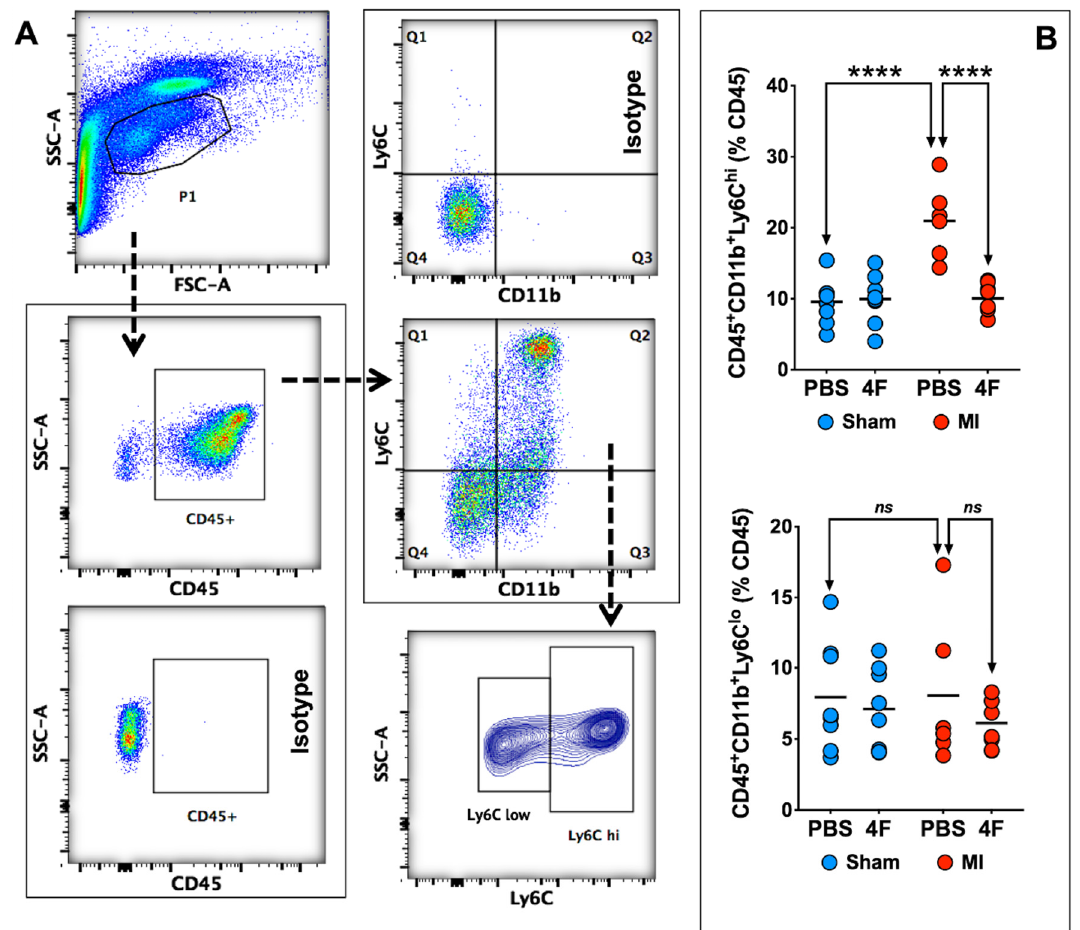
Figure 2. L-4F suppresses blood pro-inflammatory monocyte levels. ( A ) Gating strategy for flow cytometric evaluation of peripheral blood monocytes. CD45 + cells within the lymphocyte/monocyte gate (P1) were further gated on the basis of CD11b and Ly6C expression. Pro-inflammatory monocytes were identified as CD45 + CD11b + Ly6C hi cells while patrolling monocytes were identified as CD45 + Cd11b + Ly6C low cells. ( B ) Flow cytometric group data of peripheral blood monocytes after L-4F or PBS treatment post-reperfused MI. Data are depicted as percent CD45 + cells. n = 5–8/group, **** p < 0.0005. ns – not significant.